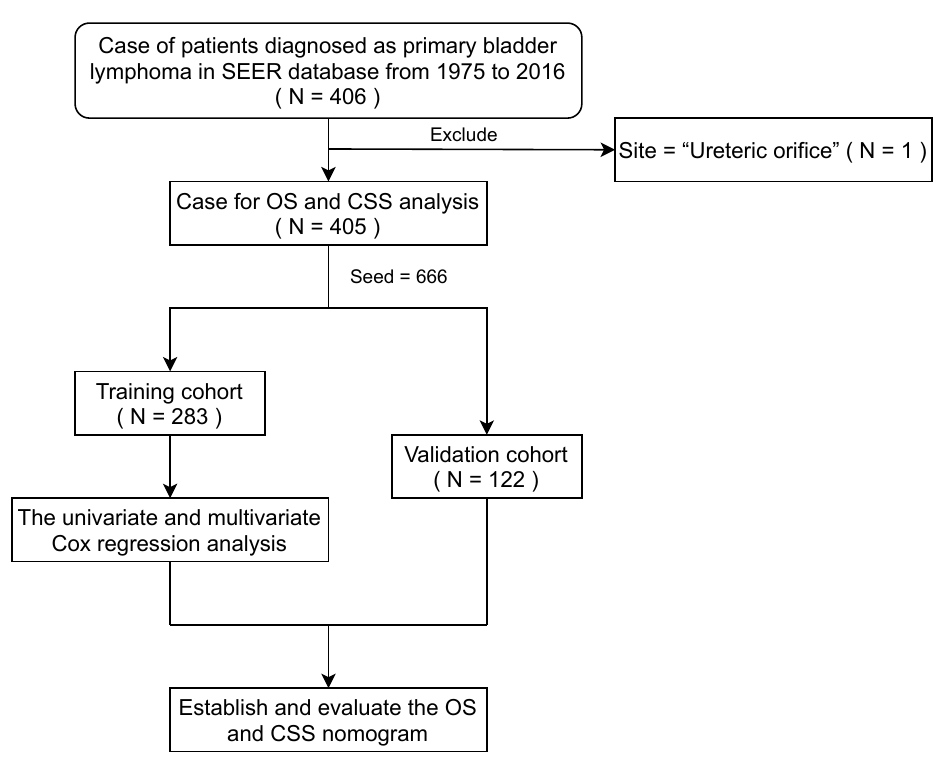
Figure 1. Flowchart of case selection and analysis process of patients diagnosed as primary bladder lymphoma from SEER database. SEER, Surveillance, Epidemiology, and End Result; OS, overall survival; CSS, cancer-specific